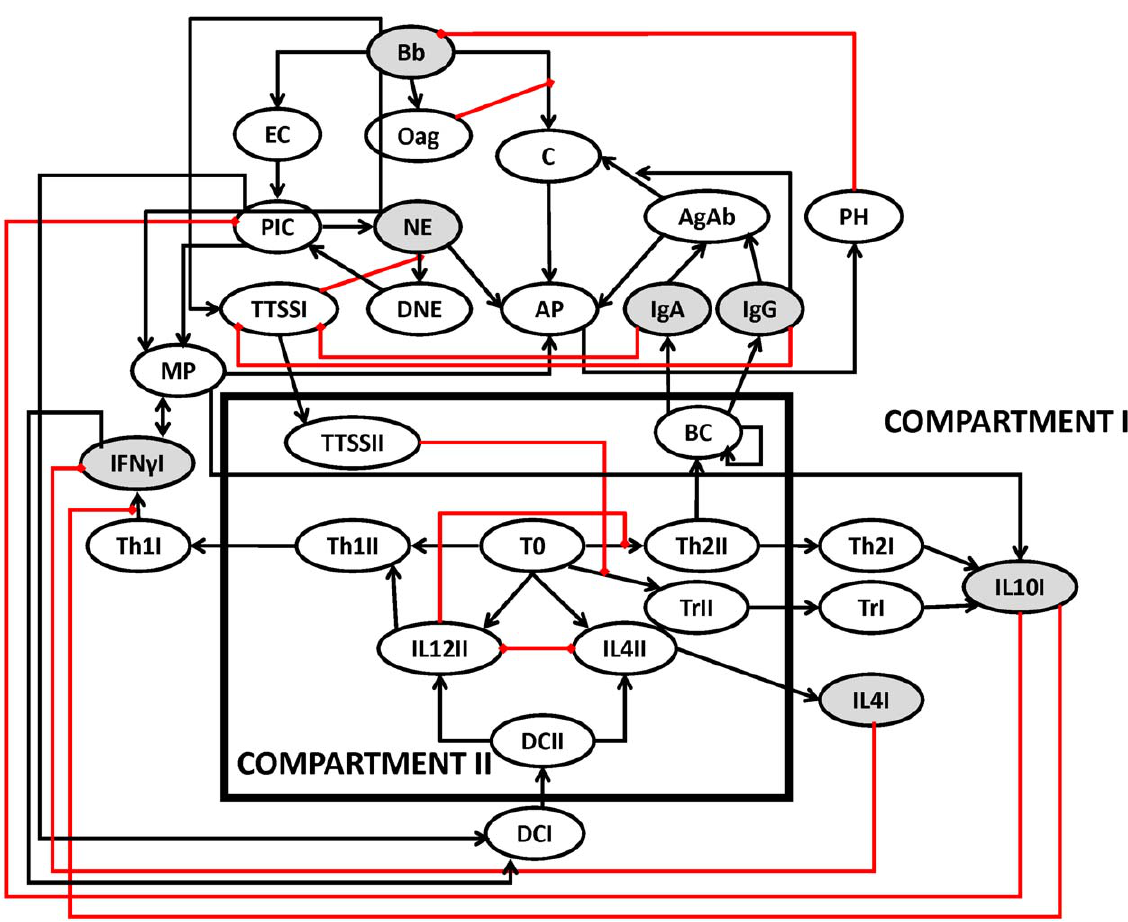
Figure 1. Network of immune components considered in single B.bronchiseptica infection. Ovals represent network nodes and indicate the node name in an abbreviated manner. Compartment I denotes the nodes in the lungs and Compartment II combines the nodes at systemic level. Terminating black arrows on an edge indicate positive effects (activation) and terminating red blunt segments indicate negative effects (inhibition). Grey nodes have been quantified in the single laboratory experiment. Abbreviations: Bb : B. bronchiseptica ; Oag : O-antigen; IL4II : Interleukin 4 in the systemic compartment; NE : Recruited neutrophils; IL12I : Interleukin 12 in lungs; IgA : Antibody A; C : Complement; TrII : T regulatory cells in the systemic compartment; IL4I : Interleukin 4 in the lungs; Th2II : Th2 cells in the systemic compartment; TrI : T regulatory cells in the lungs; Th2I : Th2 cells in the lungs; IL10II : Interleukin 10 in the lymph nodes; TTSSII : Type three secretion system in the lymph nodes; TTSSI : Type three secretion system in the lungs; IgG : Antibody G; IL10I : Interleukin 10 in the lungs; IFN c I : Interferon gamma in the lungs; IL12II : Interleukin 12 in the systemic compartment; BC : B cells; DCII : Dendritic cells in the systemic compartment; DCI : Dendritic cells in the lungs; Th1I : T helper cell subtype I in the lungs; PIC : Pro-inflammatory cytokines; Th1II : T helper cell subtype I in the systemic compartment EC : Epithelial cells; AP : Activated phagocytes; T0 : Naı¨ve T cells; AgAb : Antigen-antibody complexes; MP : Macrophages in the lungs; DNE : dead neutrophils; PH : Phagocytosis.